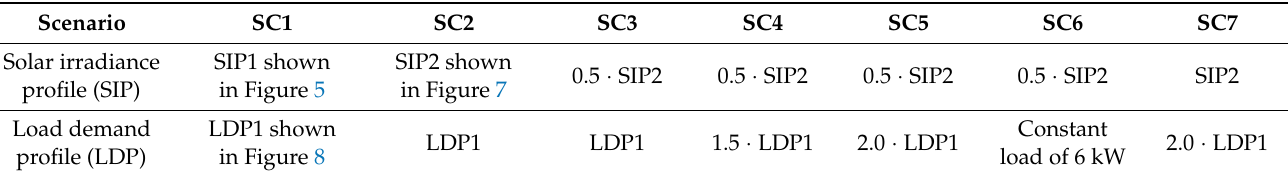
Table 2. Scenarios used to test the performance of the PV/FC/ESS